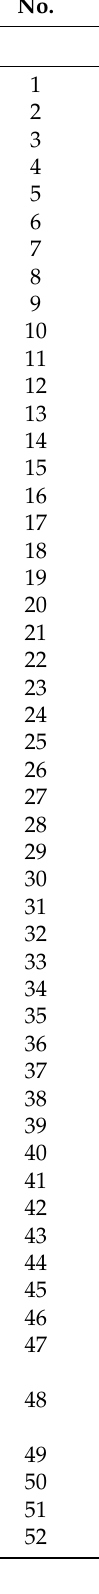
Table 1. Lignans isolated from Kadsura longipenduculata .